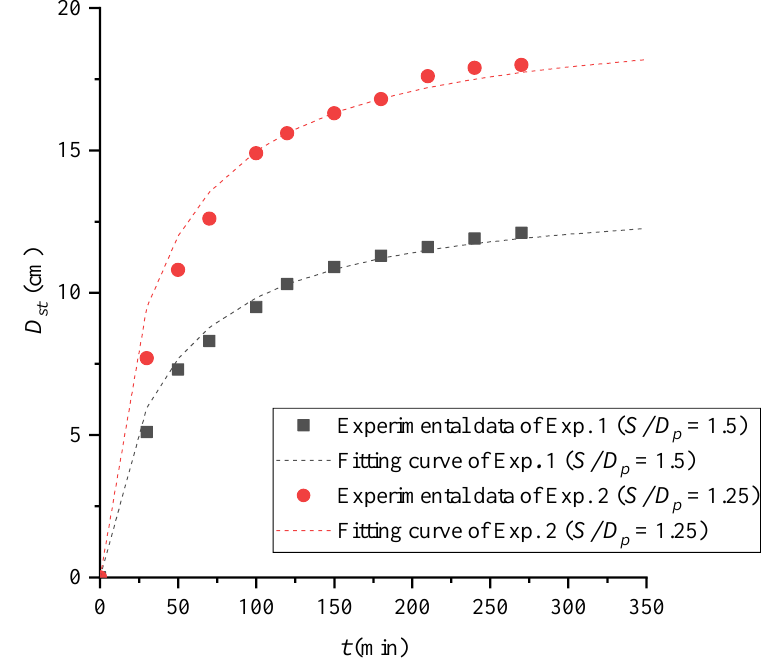
Figure 2. The temporal developments of 𝐷 𝑠𝑡 ; dash line — fitting curve calculated by Equation (3). 𝐷 𝑠𝑒 in all of our experiments were much larger than ments are shown in Figure 3.